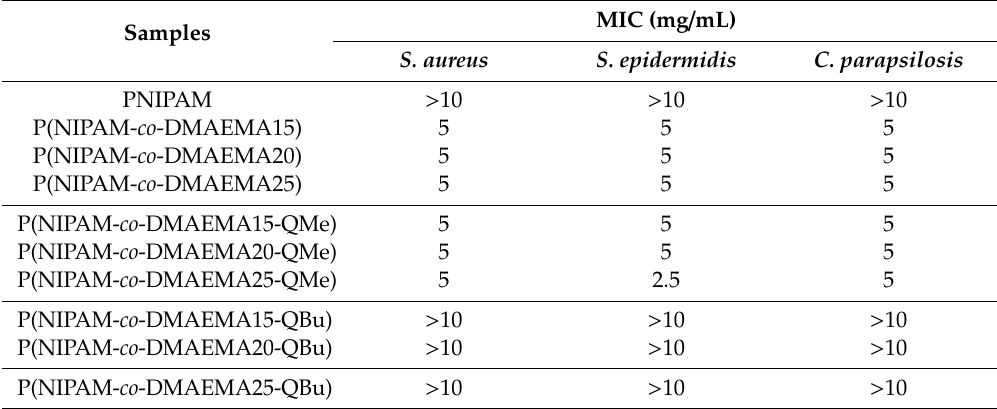
Table 3. Minimum inhibitory concentration (MIC) of microgels against gram-positive bacteria and fungi.